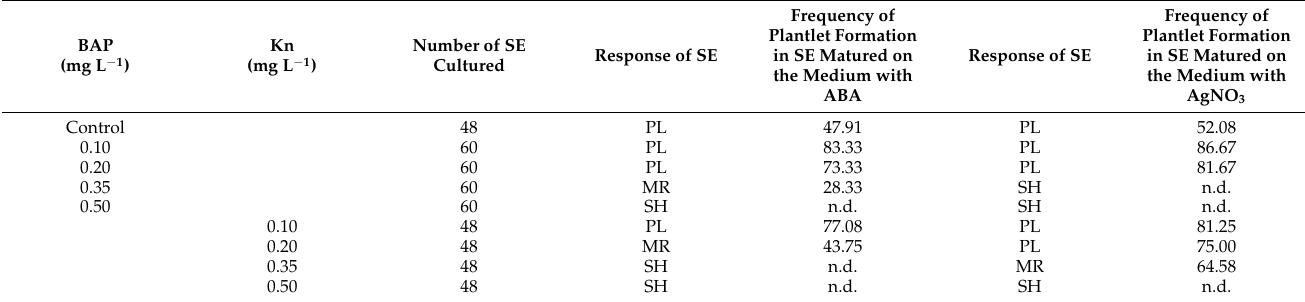
Table 4. Effect of different PGRs on conversion of somatic embryos (SE) into plantlets in V. canescens after 30 days.